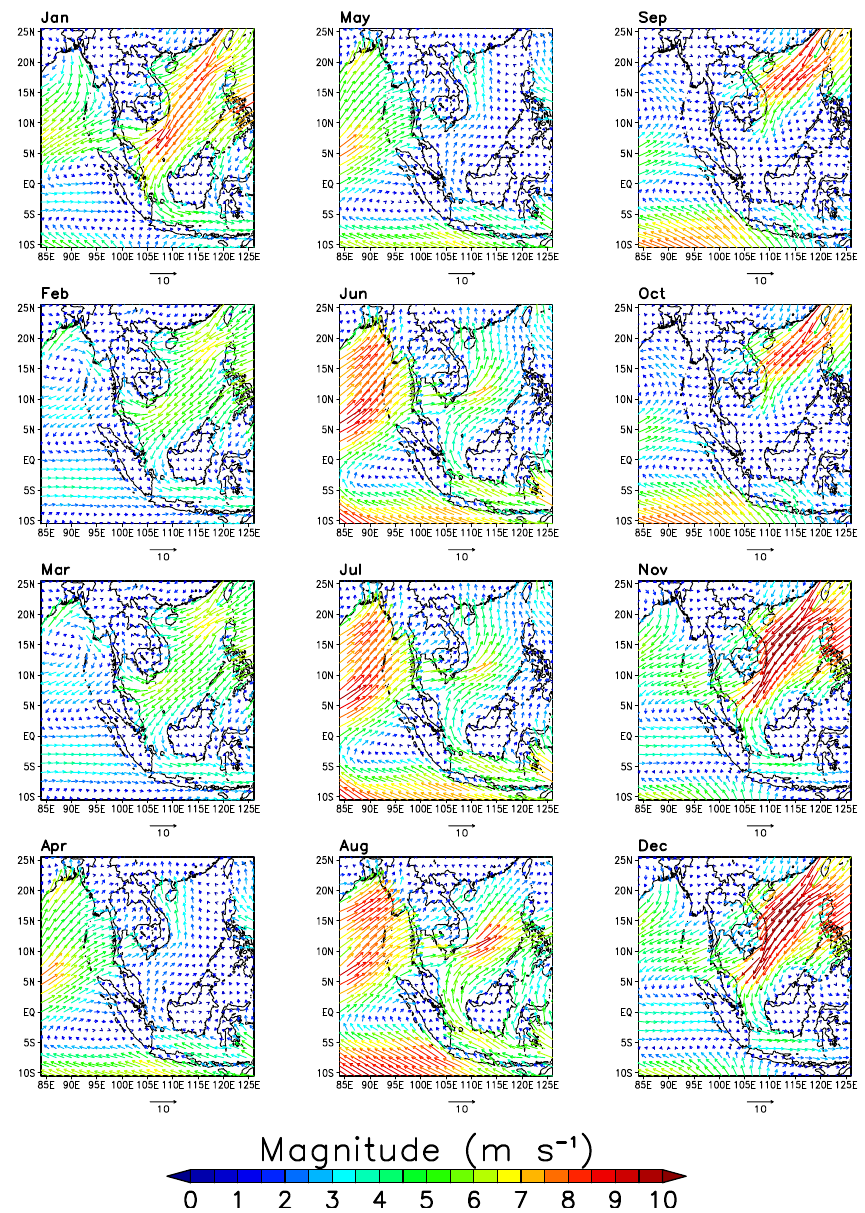
Figure 2. Monthly climatology wind vector from January 2004 to June